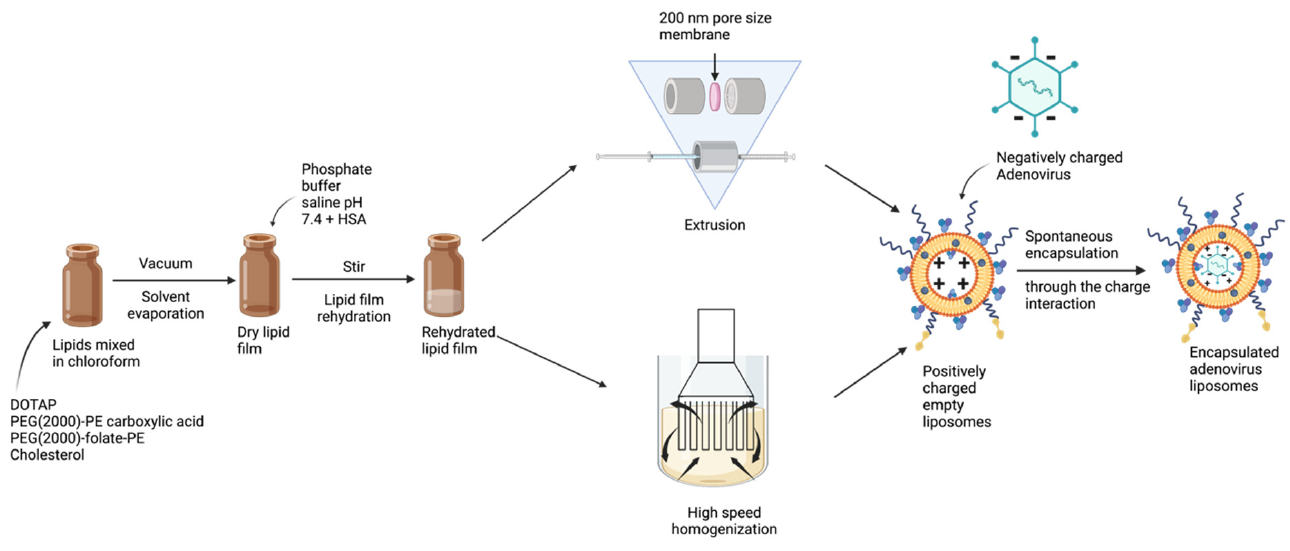
Figure 2. Two processes for manufacturing Ad liposomes: Extrusion (for small-scale) and homoge- nization (for large scale).